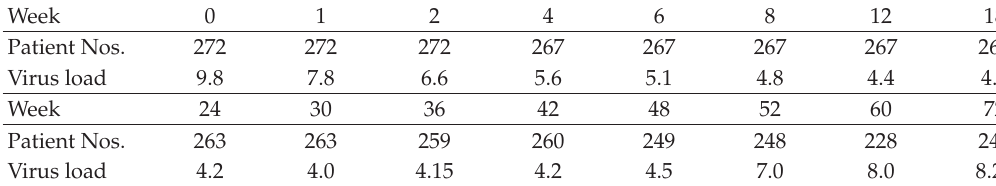
Table 1: Rapid deline in plasma virus: mean HBV DNA levels (cid:3) log copies/ml (cid:4) in response to the therapy, and the virus level returning rapidly after the treatment was